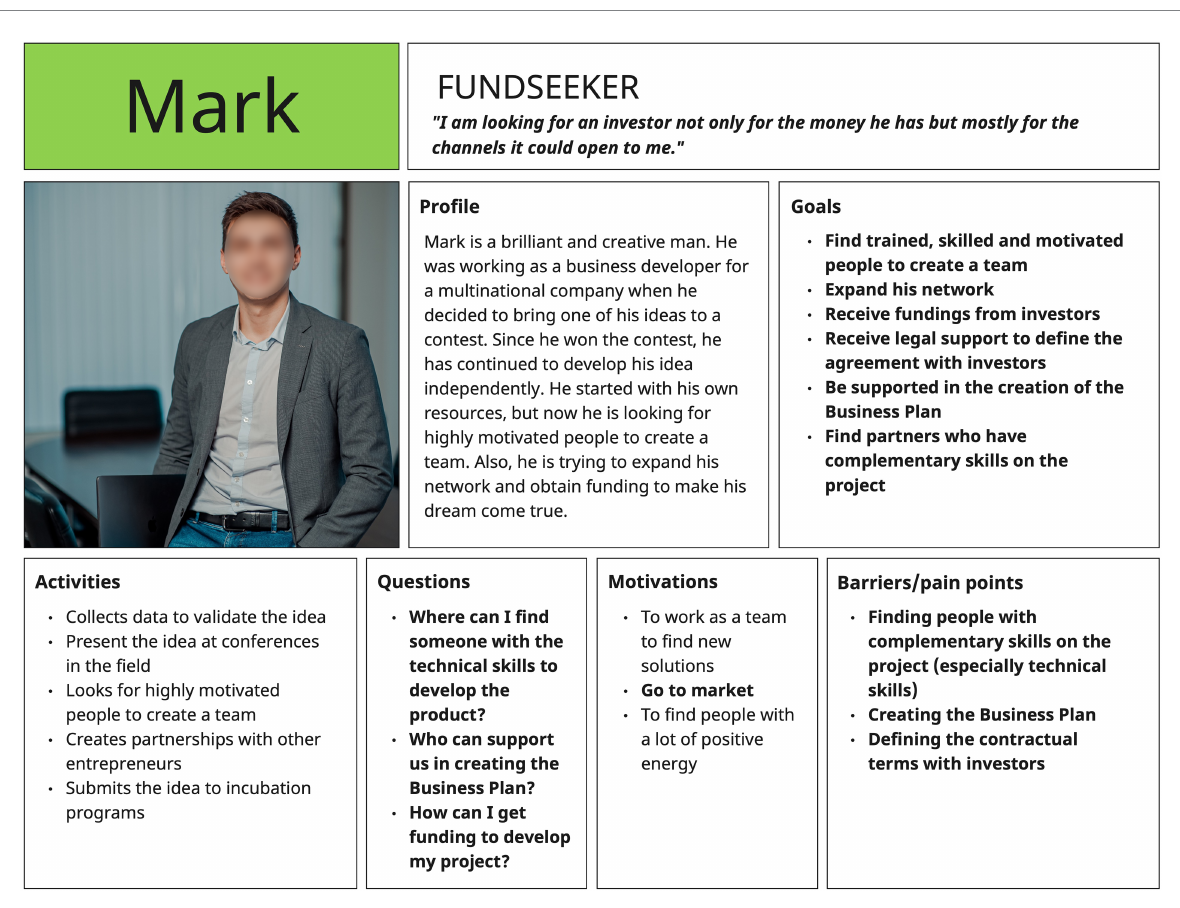
FIGURE 8 An example of Personas from a design thinking project in the field of startup funding.